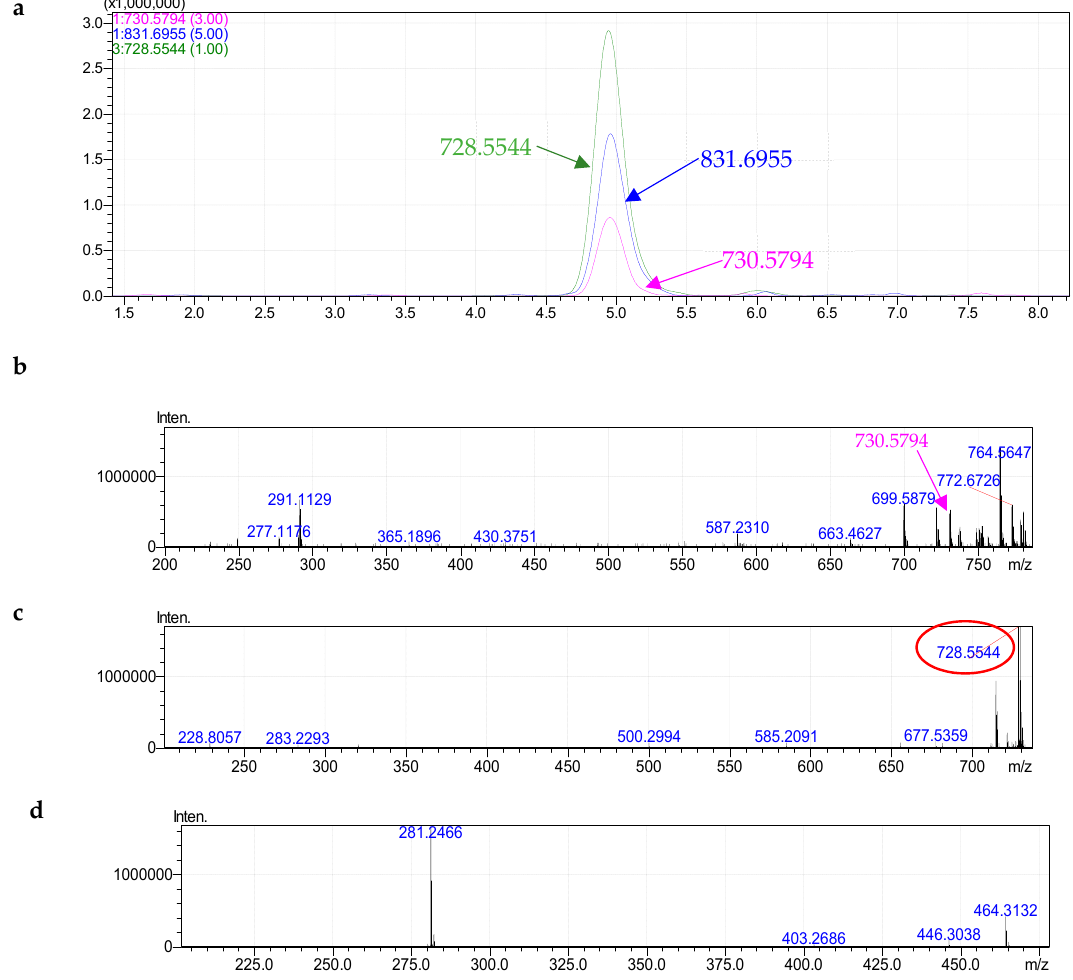
Figure 2. HPLC–HRMS ( a ) and fragmentation of PE 36:1( b —MS + , c —MS − , d —MS 2 − ).